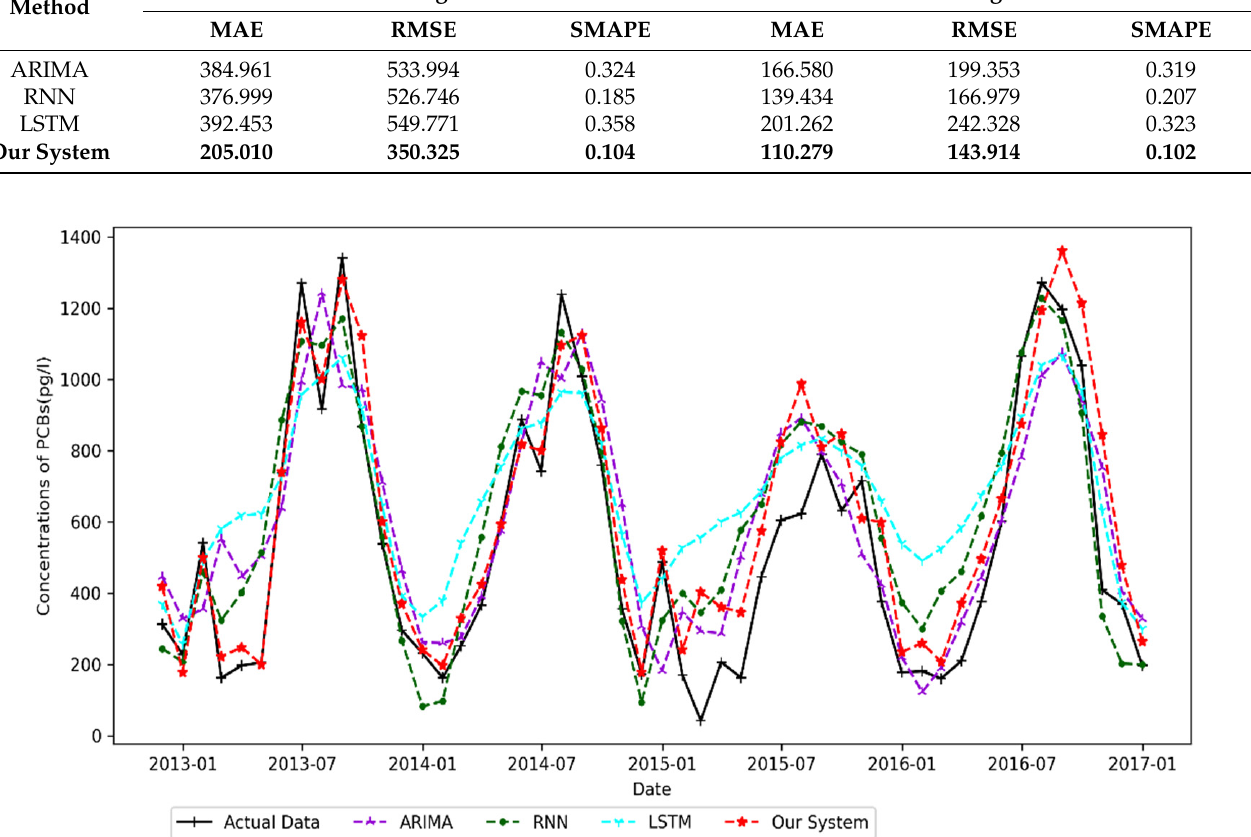
Figure 7. Prediction results of each model on Chicago dataset.